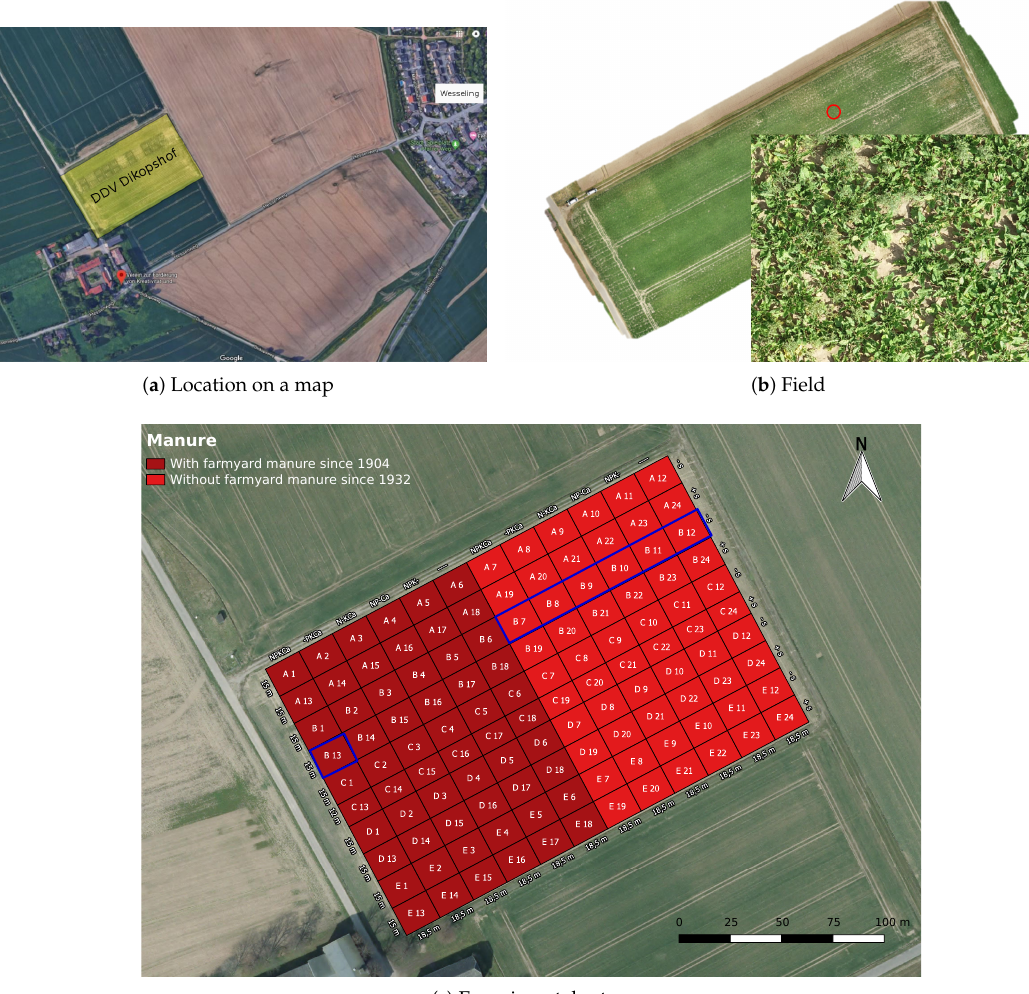
Figure 2. Aerial views of ( a ) the field ( b ) the field at the long-term fertilizer experiment (LTFE) Dikopshof, Wesseling. ( c ) Experimental setup. +s stands for supplemental fertilization. The considered plots (B7-B13) in stripe B are marked with a blue frame. Best viewed in electronic